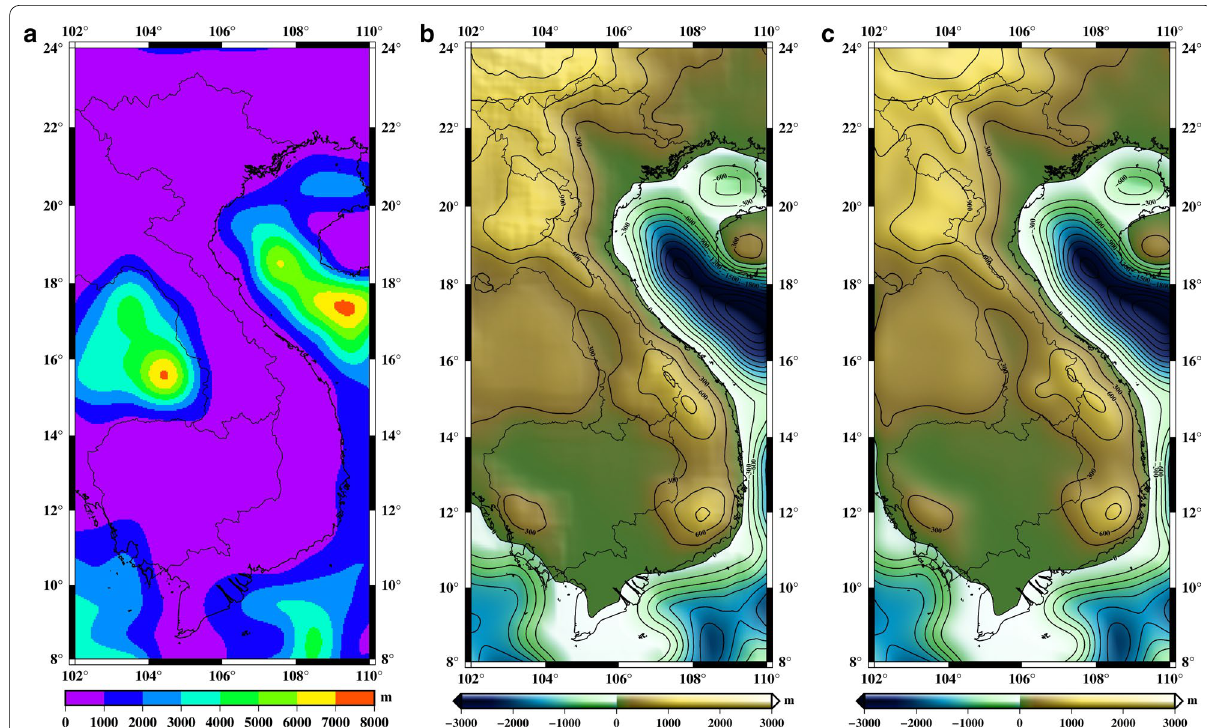
Fig. 5 a Sediment thickness derived from the CRUST1.0 model, b , c Topography-corrected sediments after removing short wavelength using simple and 2D-Gaussian filter, respectively